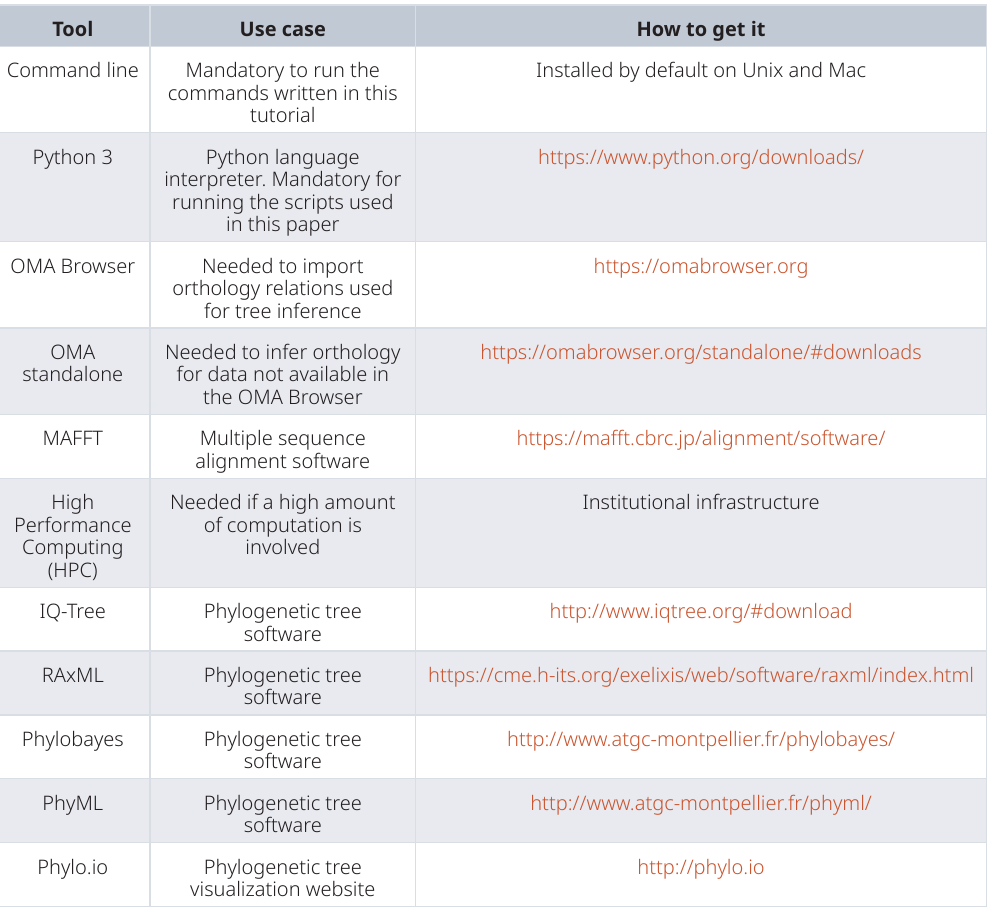
Table 1. Computational tools needed for making a phylogenetic species tree using OMA. Note that four phylogenetic tree inference software packages are given, but only one (user preference) is needed to complete this